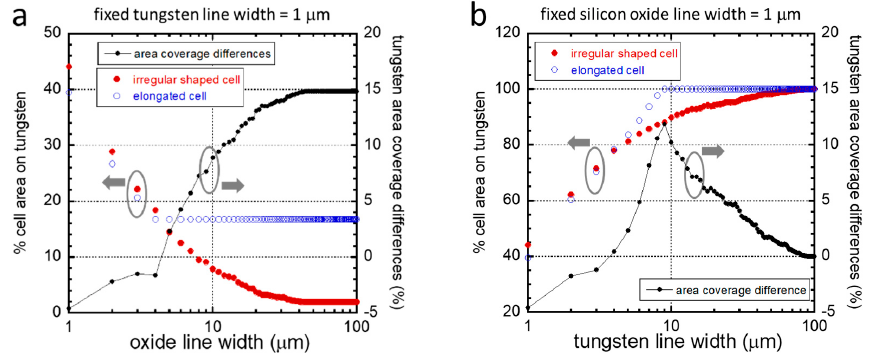
Figure 4. ( a ) Simulation result of the percent cell area in contact with W on parallel line comb structures. The tungsten line width was fixed at 1 µ m in all models, while silicon oxide line widths varied in the range of 1 µ m and 100 µ m. ( b ) Simulation result for cells on patterns with the silicon oxide line width fixed at 1 µ m in all models, while the W line width varied in the range of 1 µ m and 100 µ m. Tungsten area coverages for irregularly shaped (red close circles) and elongated (blue open circles) cells are plotted on the left axis. The nominal di ff erences in the percent area coverage between the two cell geometries (black dotted line) are plotted on the right